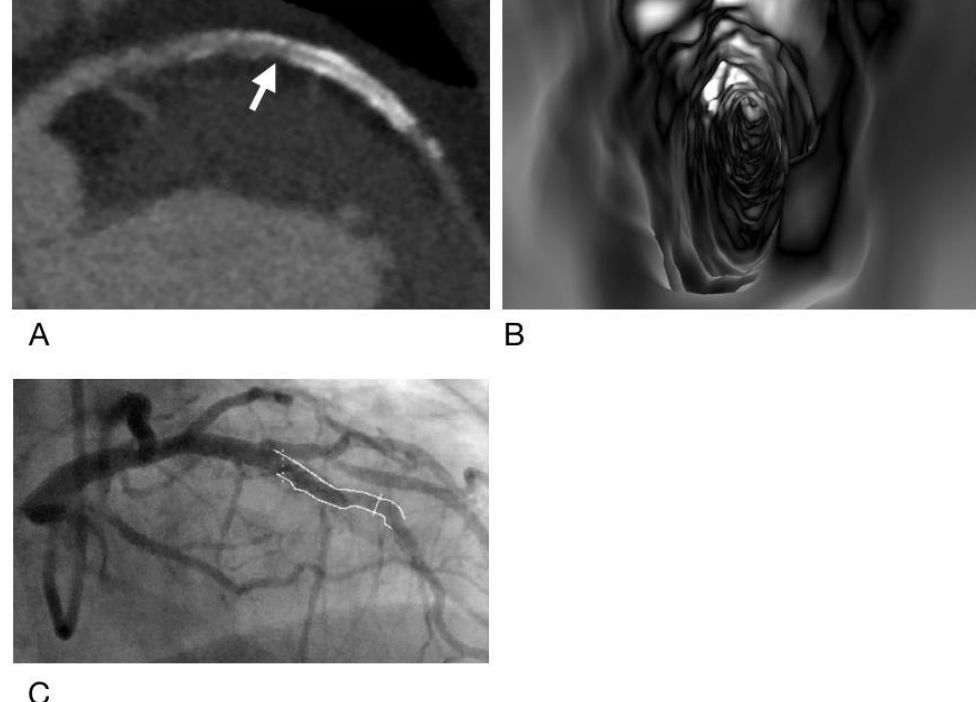
Figure 4. A case of false positive result for CCTA but true negative result for VIE. Subject is a 51-year-old man with obesity (body mass index = 32.8 kg/m 2 ) and a total calcium score of 815. A metallic stent (Xience V, 2.5 mm × 23 mm) was placed in the left anterior descending artery. CCTA ( A ) showed severe calcifications with poor opacification at the proximal end of the stent (arrow) suggestive of ISR, but VIE ( B ) found only intimal hyperplasia. ICA ( C ) showed only intimal hyperplasia with 12% stenosis in this stent.